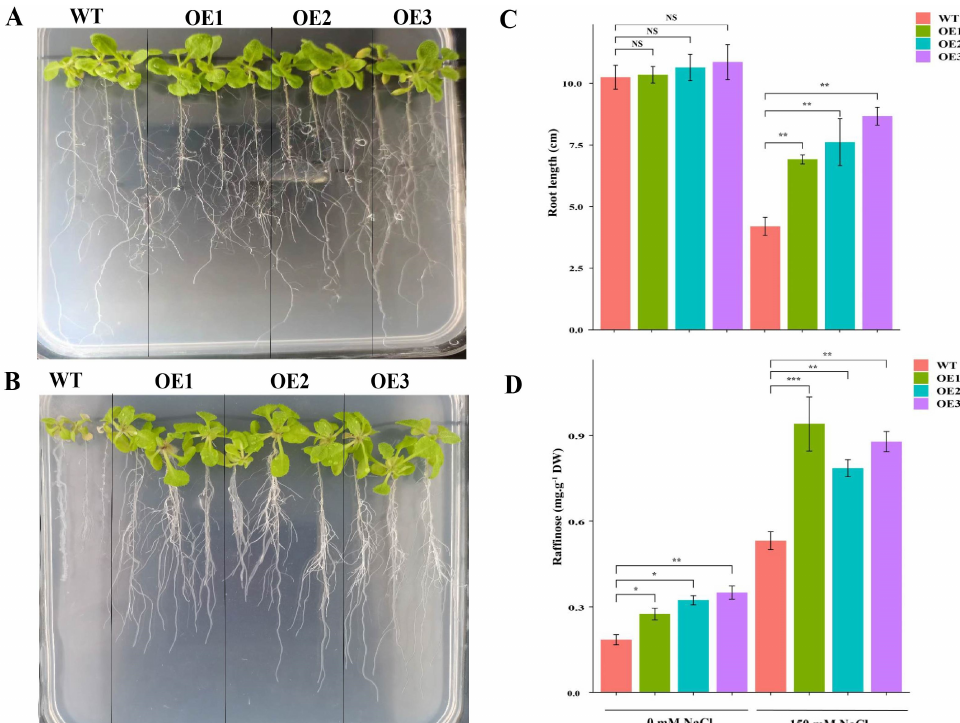
Figure 9. Overexpression of AcRFS4 results in enhanced salt tolerance. ( A ) Observation of the root length of wild type (WT) and T3 AcRFS4 -transgenic Arabidopsis seedlings (OE1, OE2 and OE3) under 0 mM NaCl. ( B ) Observation of the root length of wild type (WT) and T3 AcRFS4 -transgenic Arabidopsis seedlings (OE1, OE2 and OE3) under 150 mM NaCl. ( C ) Measurement of the root length of wild type (WT) and T3 AcRFS4 -transgenic Arabidopsis seedlings (OE1, OE2 and OE3) under different concentrations of NaCl. ( D ) Raffinose content of wild type (WT) and T3 AcRFS4 -transgenic Arabidopsis seedlings (OE1, OE2 and OE3) under different concentrations of NaCl. Three biological replicates and technical replicates calculated the error bars. Asterisk indicates significant difference compared to WT (* p < 0.05, ** p < 0.01, *** p < 0.001; one-way ANOVA test by Tukey’s test). NS indicates no significant difference compared to